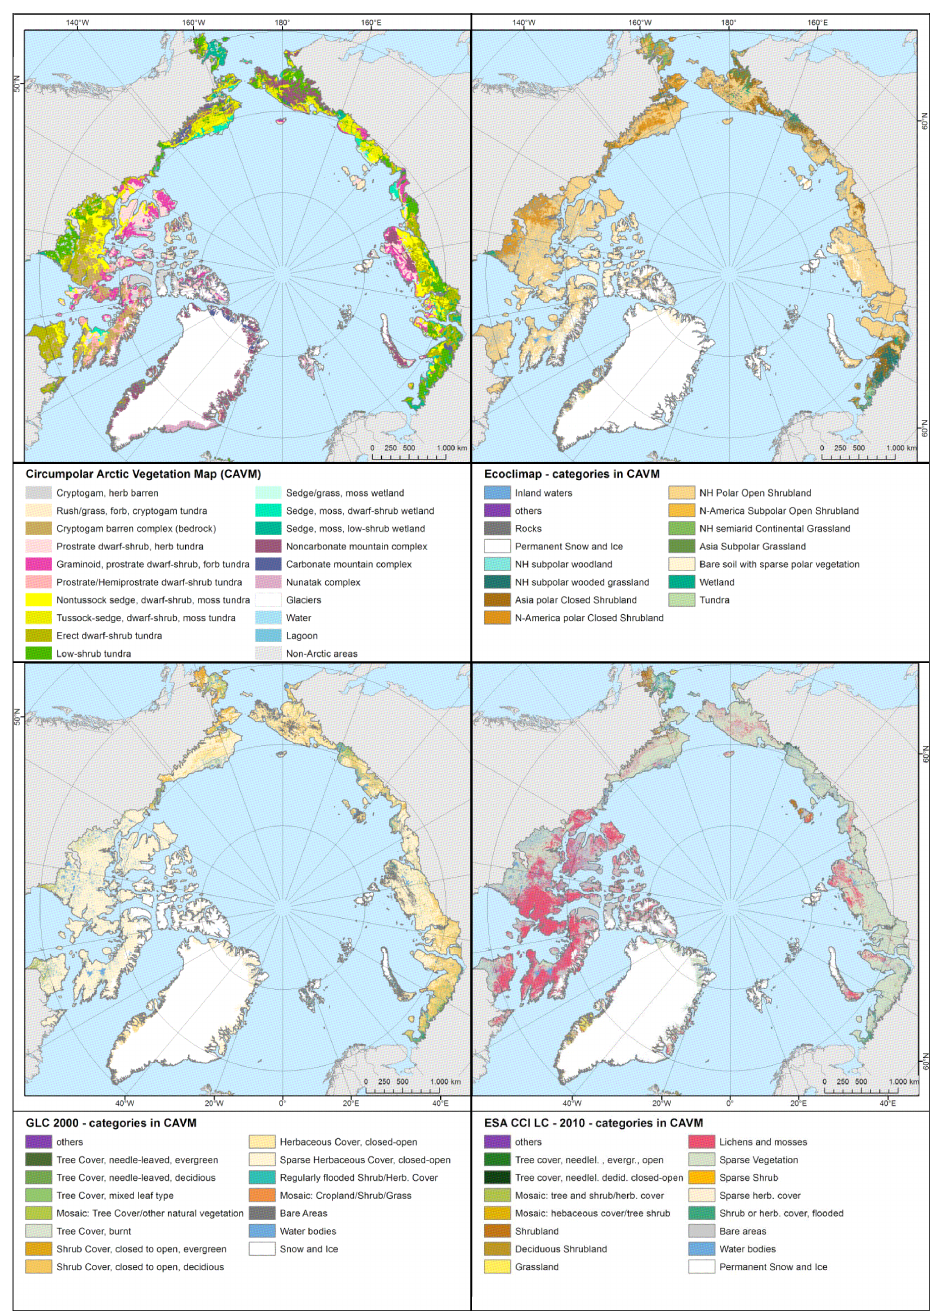
Figure 2. CAVM [5] and global land cover maps for the CAVM domain. For a description, see Table